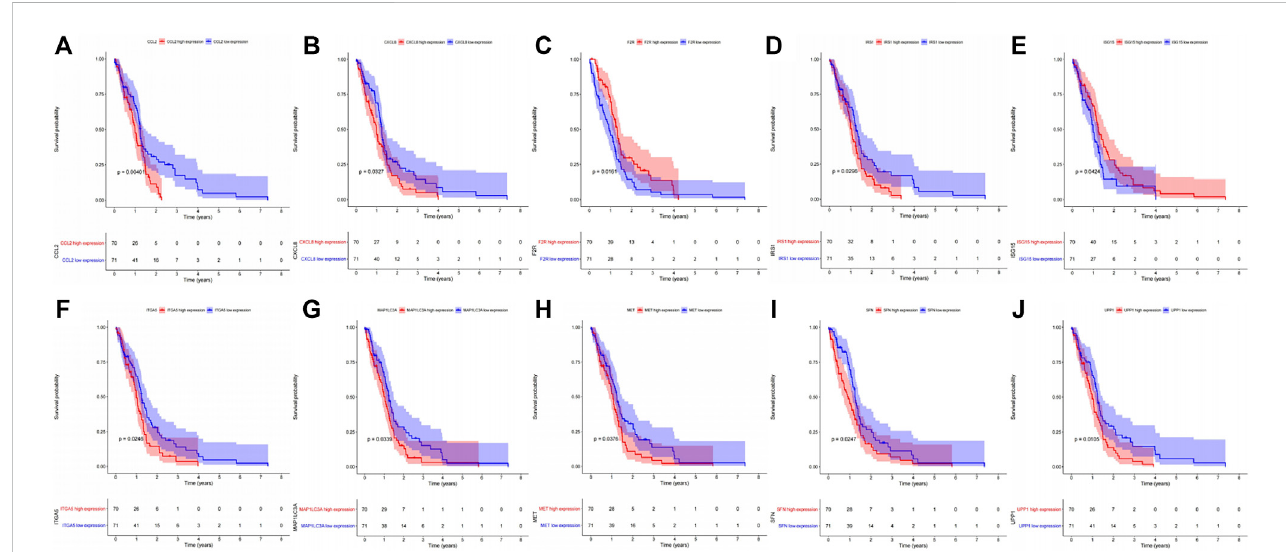
FIGURE 4 Kaplan – Meier survival analysis between high- and low-expression groups of the 10 genes extracted from the common enriched pathways with signi fi cant survival differences in the TCGA dataset. (A) CCL2. (B) CXCL8. (C) F2R. (D) IRS1. (E) ISG15. (F) ITGA5. (G) MAP1LC3A. (H) MET. (I) SFN. (J) UPP1.